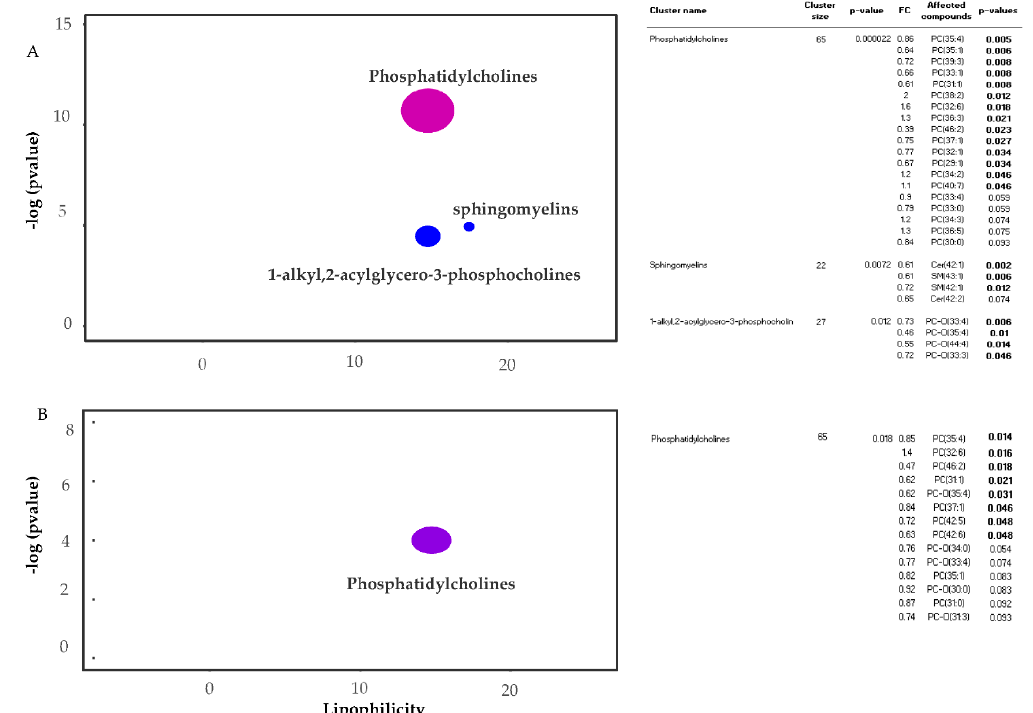
Figure 2. ChemRICH analysis plot for liver from pigs fed three or six serving of WBM. The most significant altered families of metabolites are shown on the Y -axis. Enrichment p -values are given by Kolmogorov–Smirnov test and displayed along the ordinate, with p -values transformed in − log10. Disc sizes represent the total number of metabolites in each group set. Red discs represent increased metabolites while blue represent decreased metabolites in pigs fed WBM-supplemented versus control diets. Intermediate purple color represents the presence of both increased and decreased metabolites. ChemRICH impact plot for three servings of WBM vs. control fed pigs ( A ) and for six servings of WBM vs. control fed pigs ( B ) with corresponding statistic table for each metabolite cluster. p -values < 0.05 in bold.